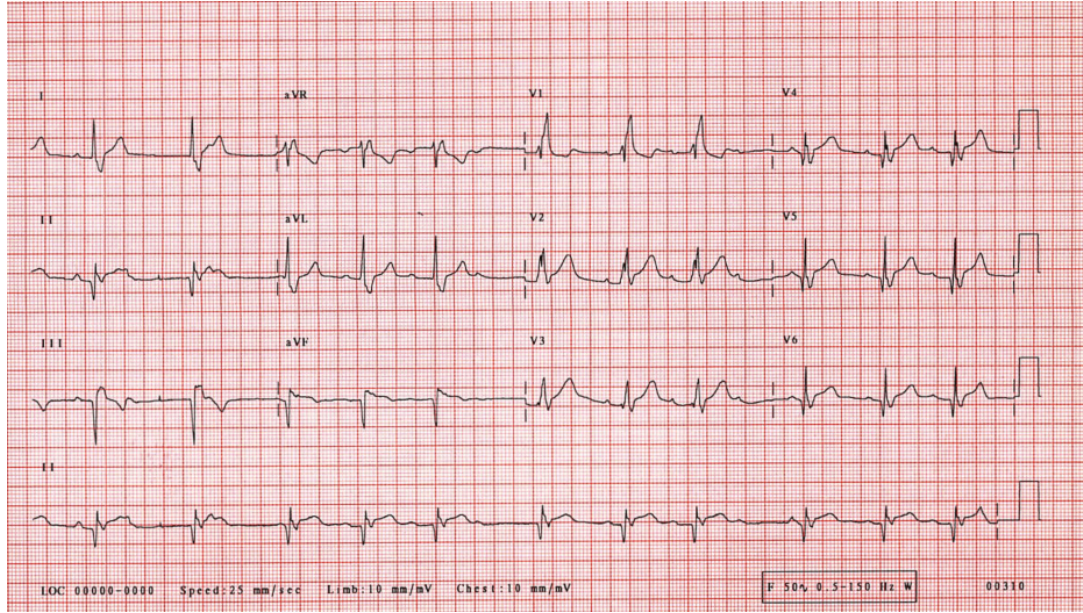
Figure 1. The electrocardiogram shows sinus rhythm, right bundle branch block, and right heart overload.